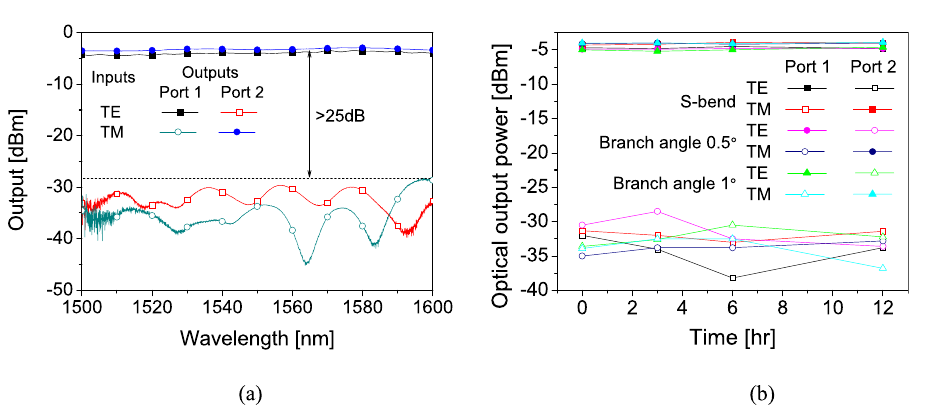
Figure 4. ( a ) Measured wavelength dependence over the wavelength range of 1500~1600 nm, and a crosstalk of less than − 20 dB was found, and ( b ) Thermal stability of the fabricated polarization splitter with various branch